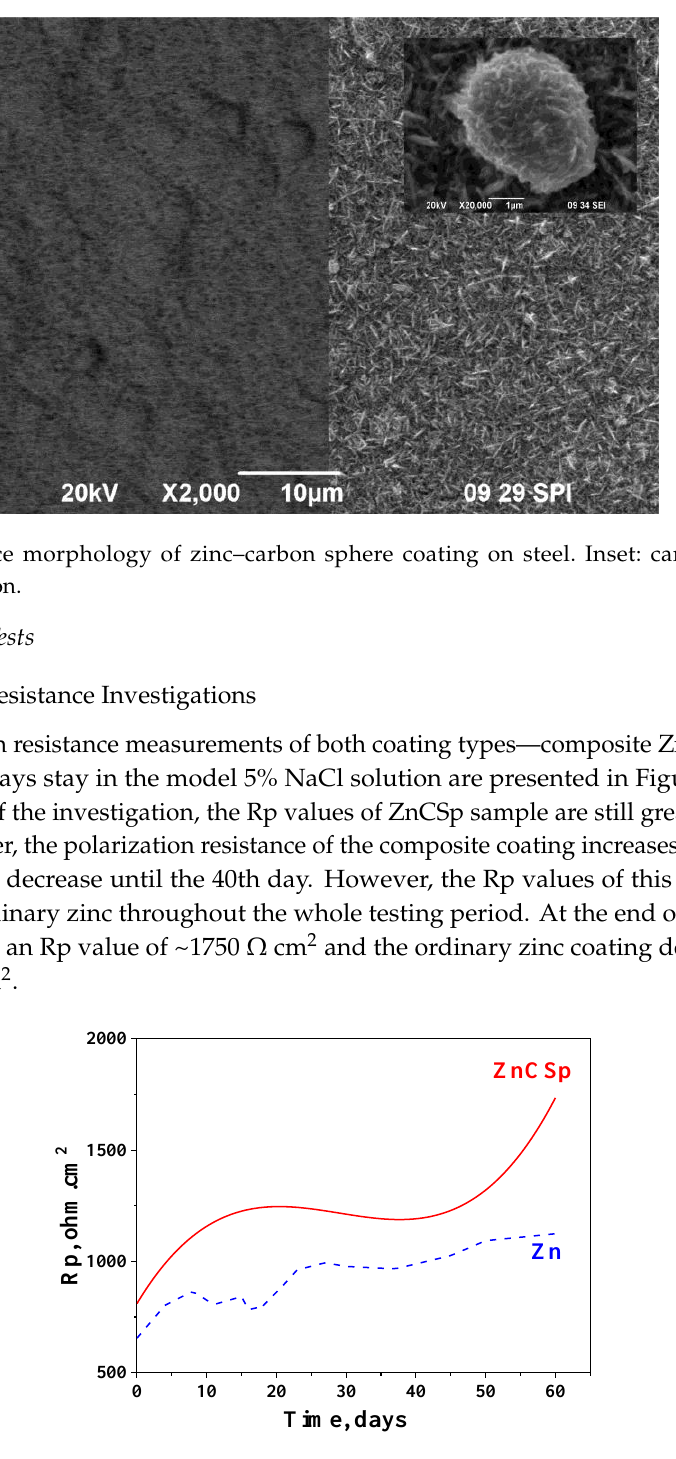
Figure 4. Polarization resistance measurements of Zn and ZnCSp coatings.